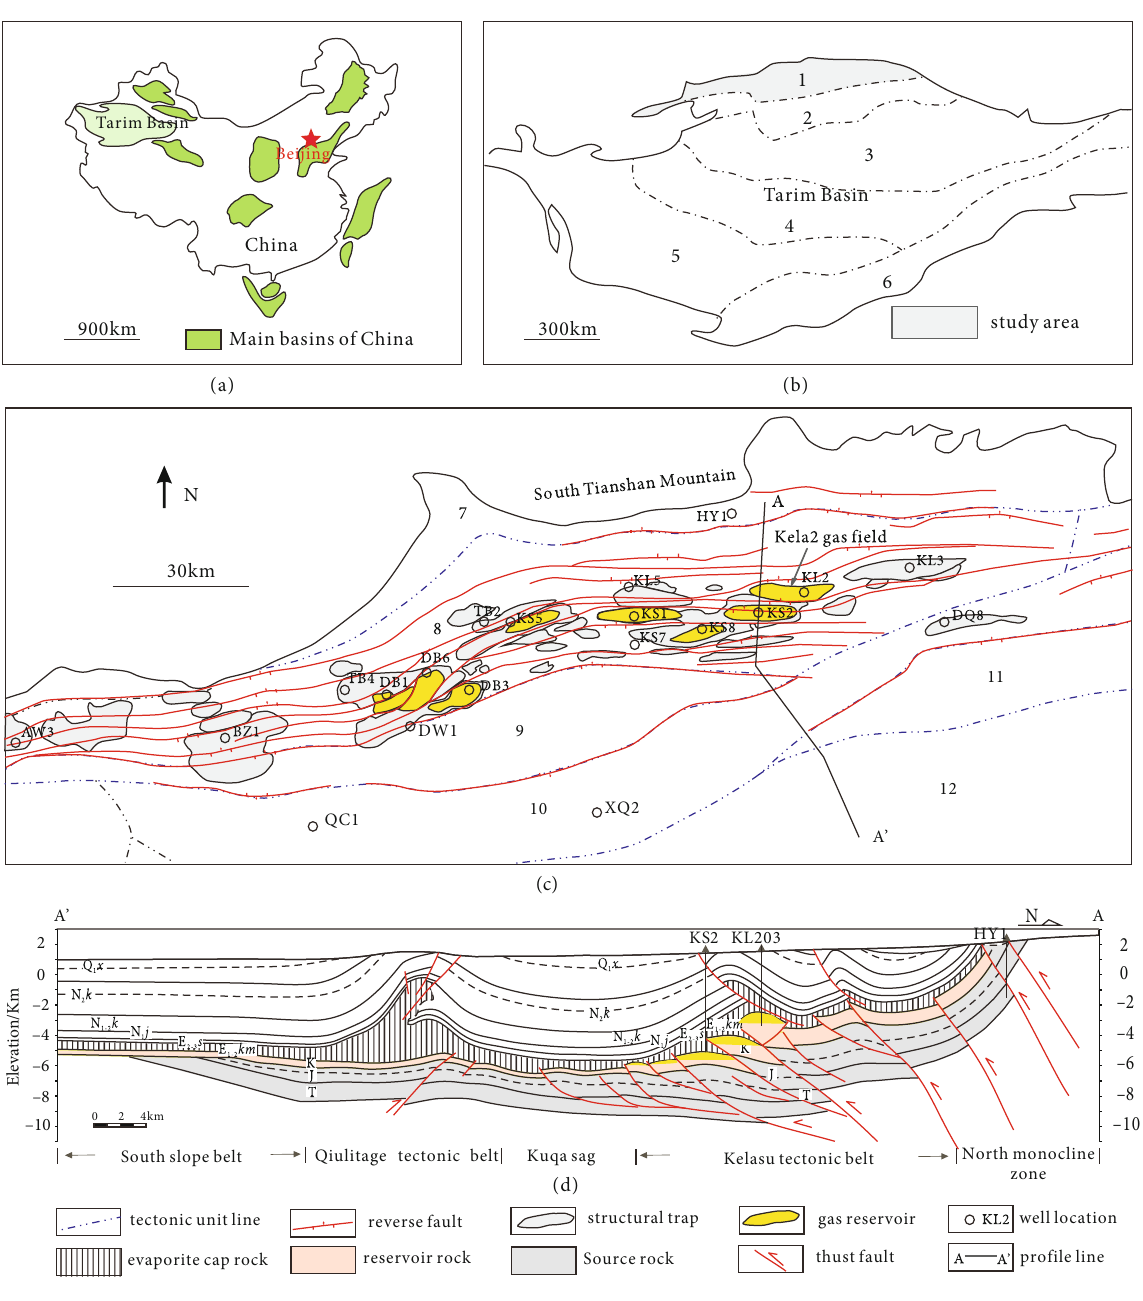
Figure 1: (a) Map of the Kuqa foreland basin, showing the location and geology of the Kela-2 gas fi eld. (b) Geological cross-section A – A ’ across the Kela-2 gas fi